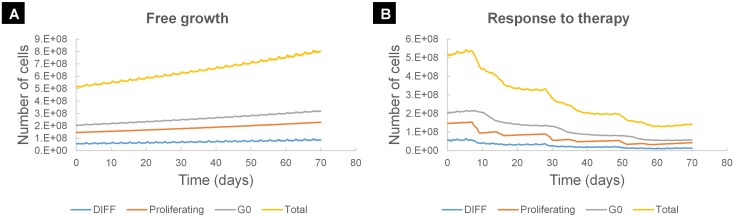
Simulated time course of selected cancer cell populations.(A) Various tumor cell populations as a function of time in the case of free tumor growth. A homogeneous spherical tumor of 10mm diameter is considered. The values of code input parameters that regulate tumor growth kinetics are given in Table 5 (Squamous Cell Carcinoma—SCC representative case). (B) Various tumor cell populations as a function of time in the case of treatment response. A homogeneous spherical tumor of 10mm diameter is considered. A cell cycle specific (gemcitabine) and a cell cycle non-specific (cisplatin) drug are administered as a three-week cycle. Gemcitabine is given on days 7, 14, 28, 35, 49, 56. Cisplatin is administered on days 7, 28 and 49. After each chemotherapeutic session a drop in the various tumor cell populations is observed, followed by tumor repopulation. The values of code input parameters are given in Table 5 (Squamous Cell Carcinoma—SCC representative case). Abbreviations: DIFF: terminally DIFFerentiated tumor cell, G0: dormant, resting phase.